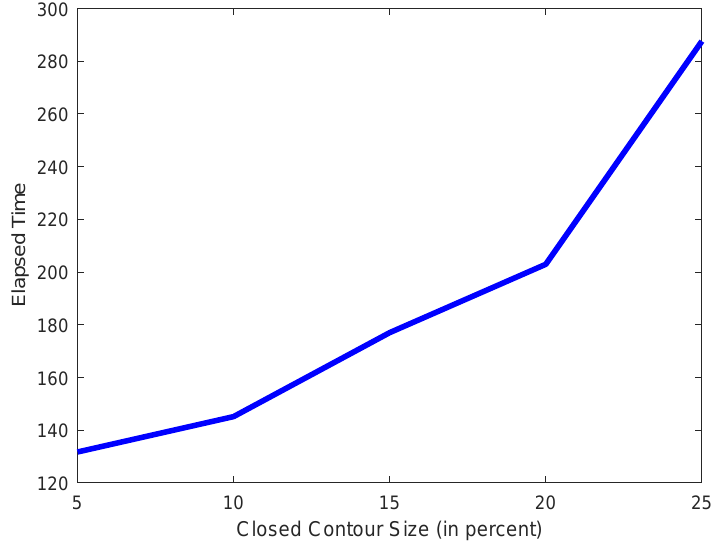
Figure 10. Plot of elapsed time vs. contour size.